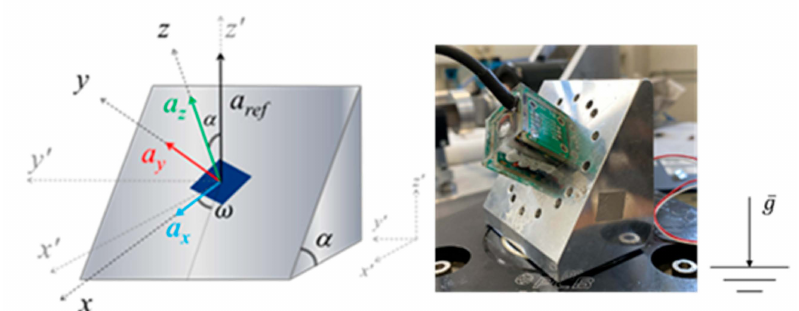
Figure 10. The multicomponent calibration system: inclined plane allows to generate a projection of the vertical reference acceleration along three axes